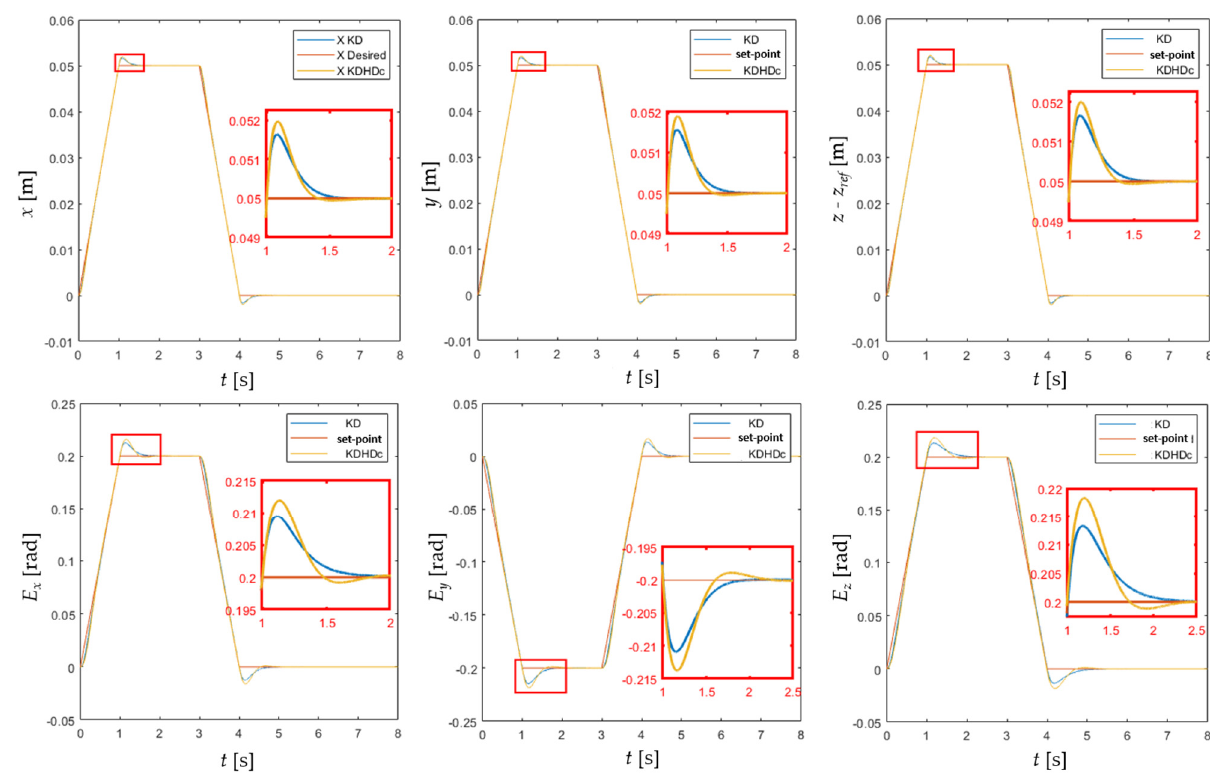
Figure 3. Case study A, KD–KDHDc comparison, external coordinates.